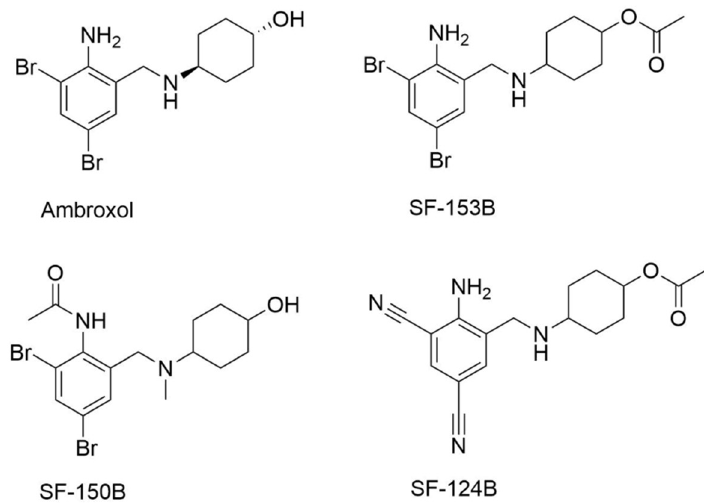
Figure 4. Ambroxol and its derivatives.